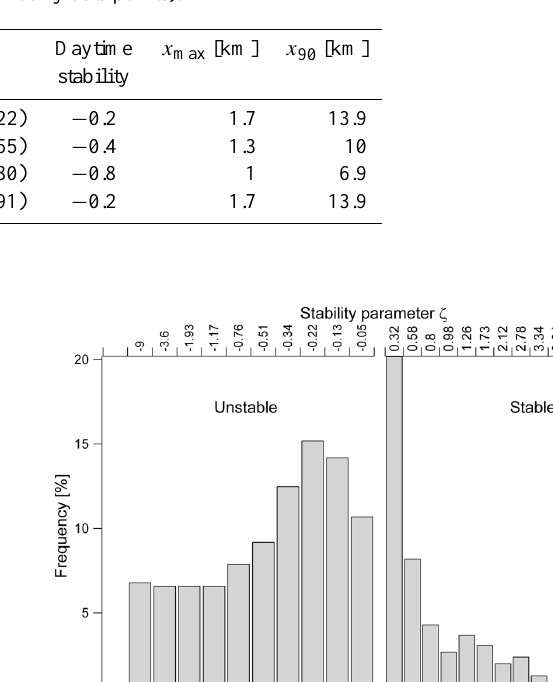
Table 1. Median seasonal daytime (09:00–18:00) stability and fetch parameters x max (distance from the measurement point contributing the most to the observed flux) and x 90 (distance from the measurement point where 90% of the cumulative flux is realised). x max and x 90 were obtained from the Kormann-Meixner model for each 30 min stability value. Seasonal data coverage is given both in relative (percentage of available data points) and absolute terms (number of available half-hourly data points).